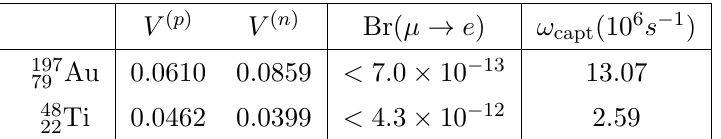
Table 2 . The relevant overlap integrals in units of m 5 = 2 (cid:22) , the branching ratio at 90% con(cid:12)dence level and the total capture rates for di(cid:11)erent